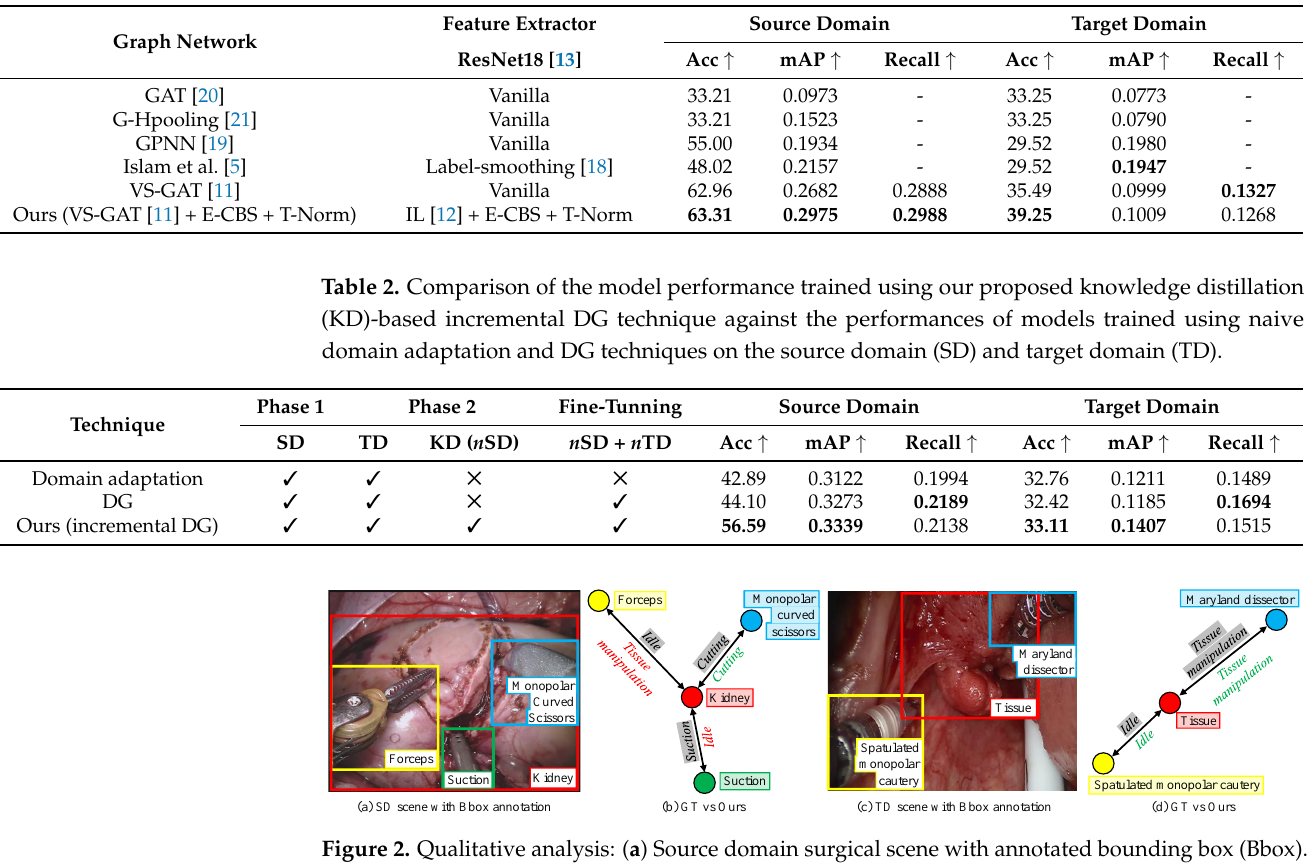
Table 1. Comparison of our proposed model’s performance in the source and target domains against the state-of-the-art scene graph models when trained solely on source domain.